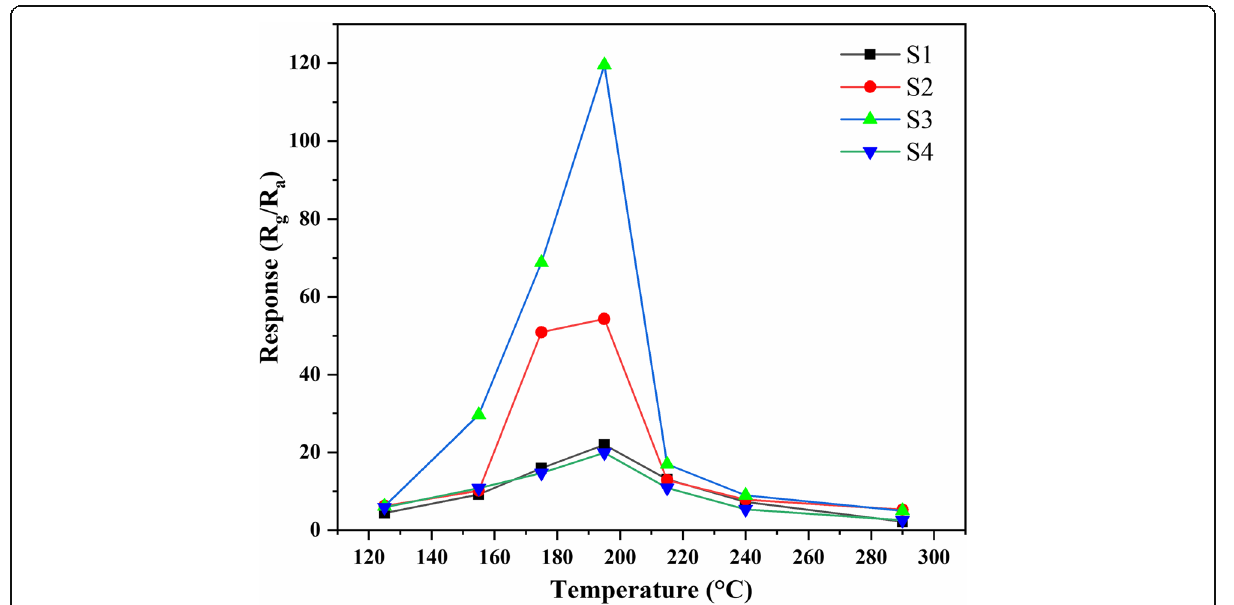
Fig. 7 Relationship between response and operating temperature to 5 ppm methanol based on S1, S2, S3, and S4